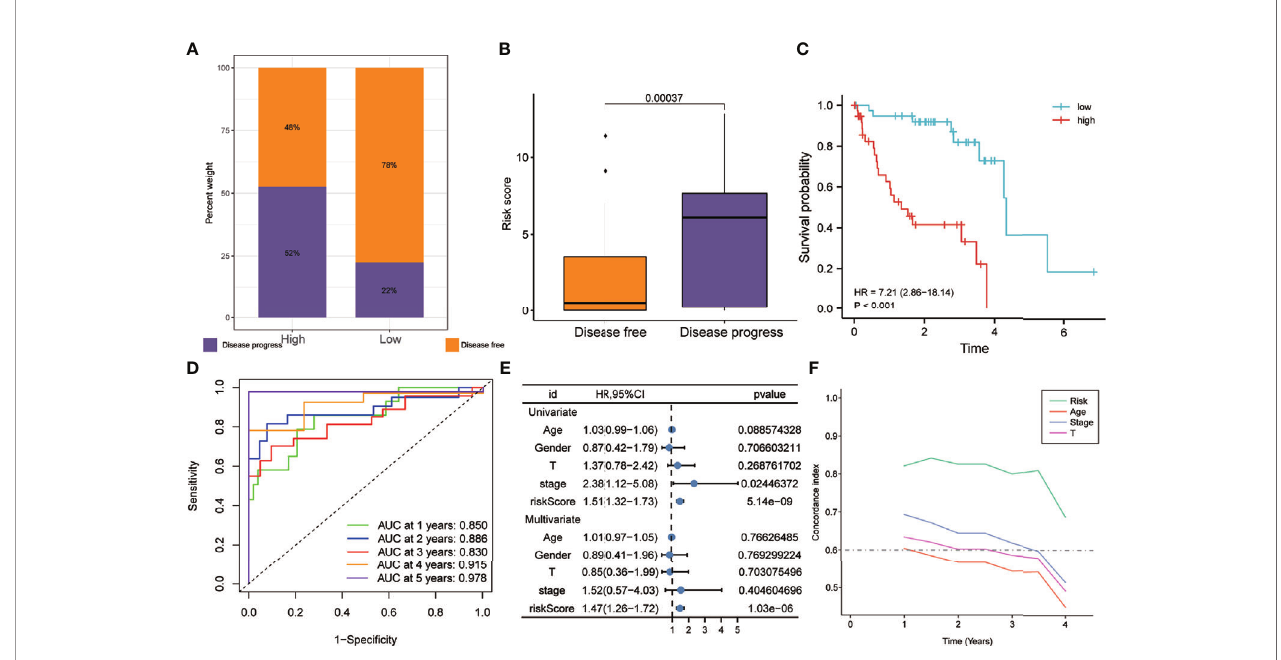
FIGURE 5 | Risk score predicts a higher rate of disease progression in the training set. (A) The proportion of patients with disease progression in the high-risk group was higher. (B) Patients with disease progression had higher risk scores. (C) Patients in the high-risk group exhibited worse PFS. (D) The receiver operating characteristic (ROC) curve showed good predictive accuracy of the risk score on PFS (AUC > 0.8). (E) Univariate and multivariate Cox regression analyses showed that risk score was an independent risk factor for PFS. (F) The t-ROC analysis showed that the survival predictive power of the risk model was signi fi cantly better than that of other clinical features. AUC , area under the ROC curve; HR , risk ratio; PFS , progression-free survival; t-ROC , time-dependent receiver operating